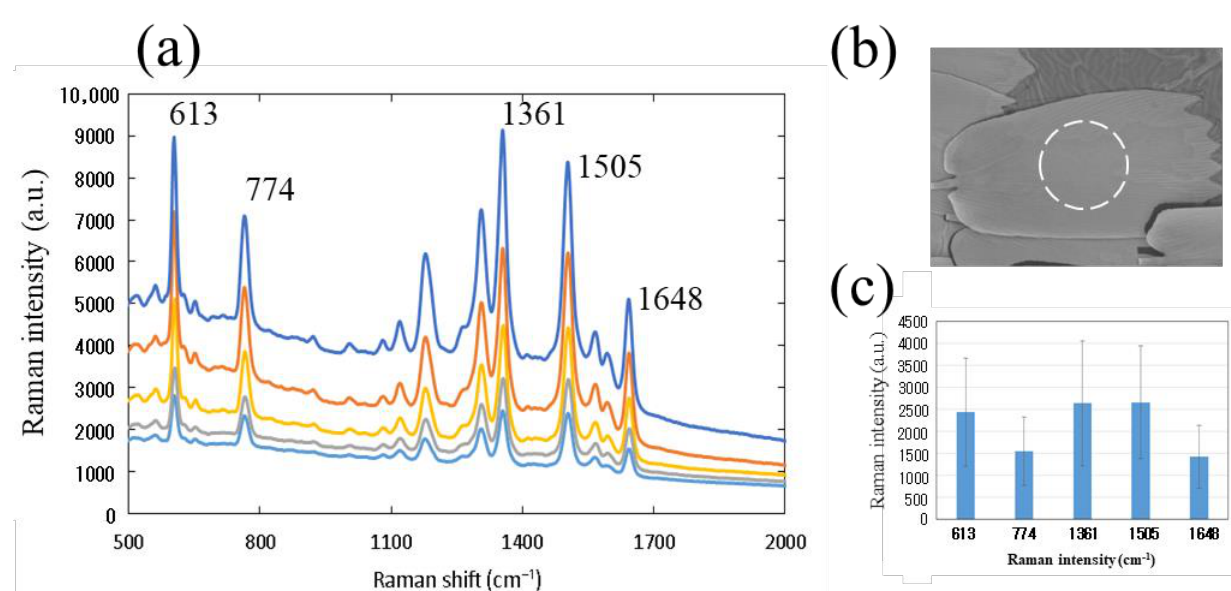
Figure A4. Variability in SERS spectra. ( a ) SERS spectra of 1 mM R6G obtained from five randomly chosen spots from a cream scale covered by 100 nm silver. ( b ) An SEM image (Hitachi TM3000) showing a general central area from where SERS spectra were obtained. ( c ) Intensities of five characteristic bands at 613, 774, 1361, 1505 and 1648 cm − 1 .